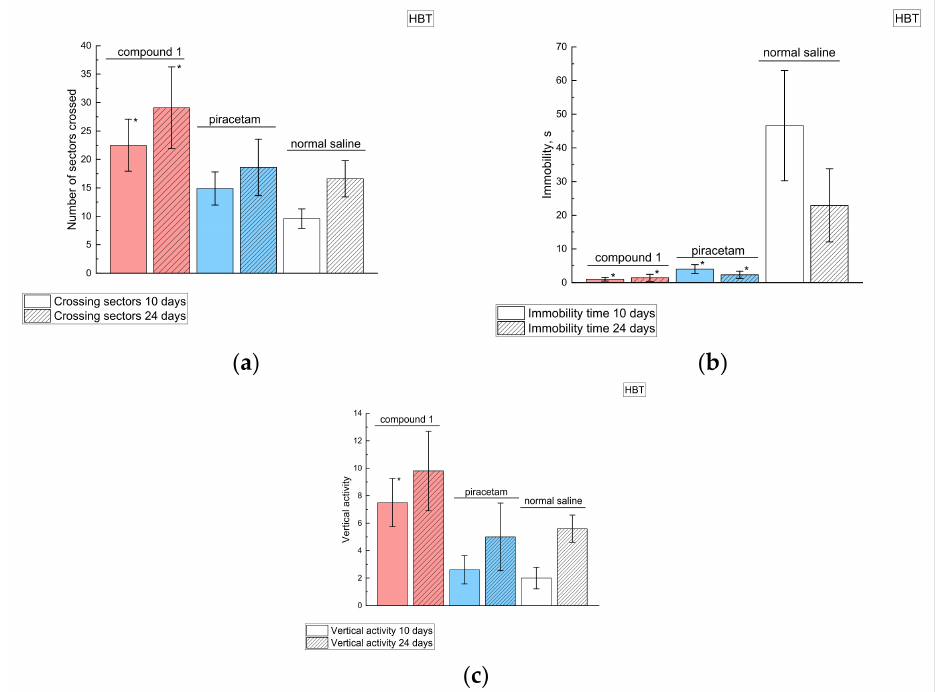
Figure 4. Results of the HBT test. ( a )—the average number of sectors crossed; ( b )—immobility time; ( c )—vertical activity. Empty rectangle—data for day 10; a rectangle with shading—data for day 24. The results are expressed as the mean ± standard error (SD). * p < 0.05. Animals in the experimental group demonstrated increased motor activities and decreased